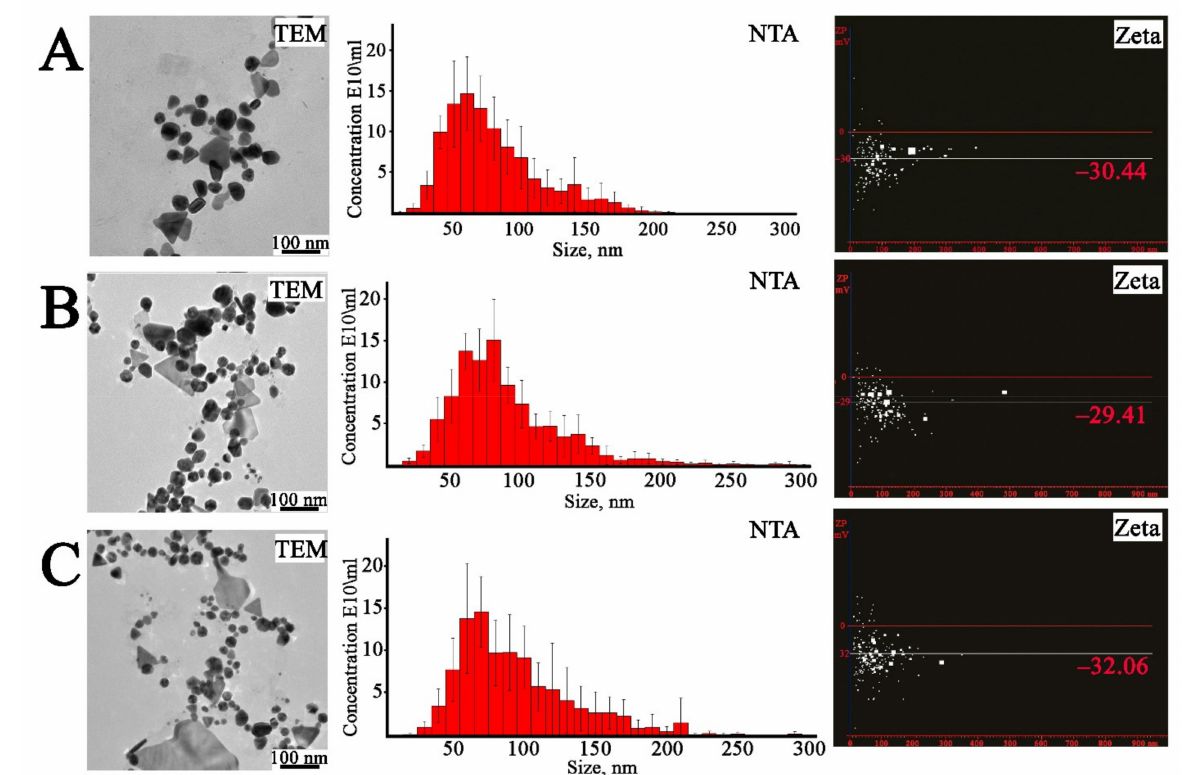
Figure 7. Analysis of bimetallic Ag/Au NPs synthesized with L . erythrorhizon callus extract. TEM—transmission electron microscopy images; NTA—nanoparticle tracking analysis; Zeta—measurement of electric potential using NTA. ( A )—Ag/Au